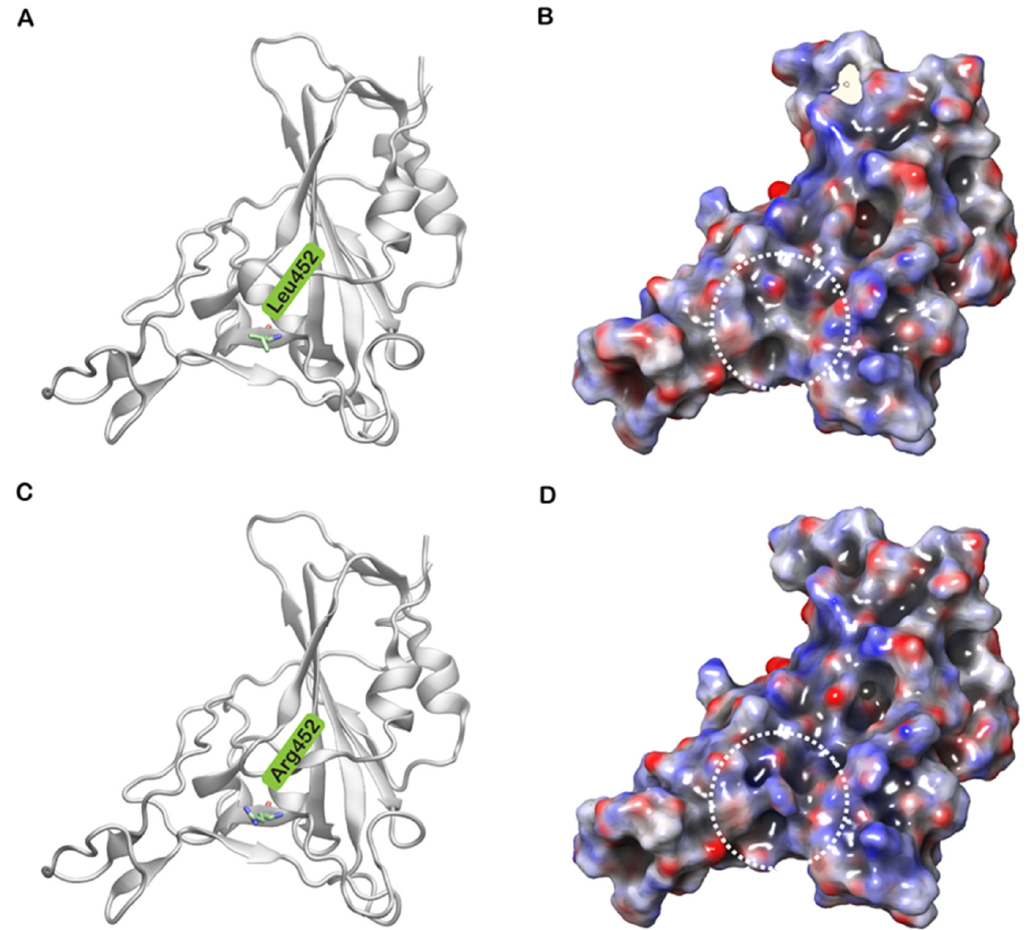
Figure 5. ( A ) Cartoon representation of the SARS-CoV-2 spike (S) protein receptor-binding domain (RBD) of wild type with Leu452 shown in stick representation. ( B ) The electrostatic potential, calculated using Adaptive Poisson–Boltzmann Solver (APBS), mapped on to the surface of the wild type protein. ( C ) Cartoon representation of the S protein RBD of the mutated Arg452 shown in stick representation. ( D ) The electrostatic potential, calculated using APBS, mapped on to the surface of the mutant protein (L452R).